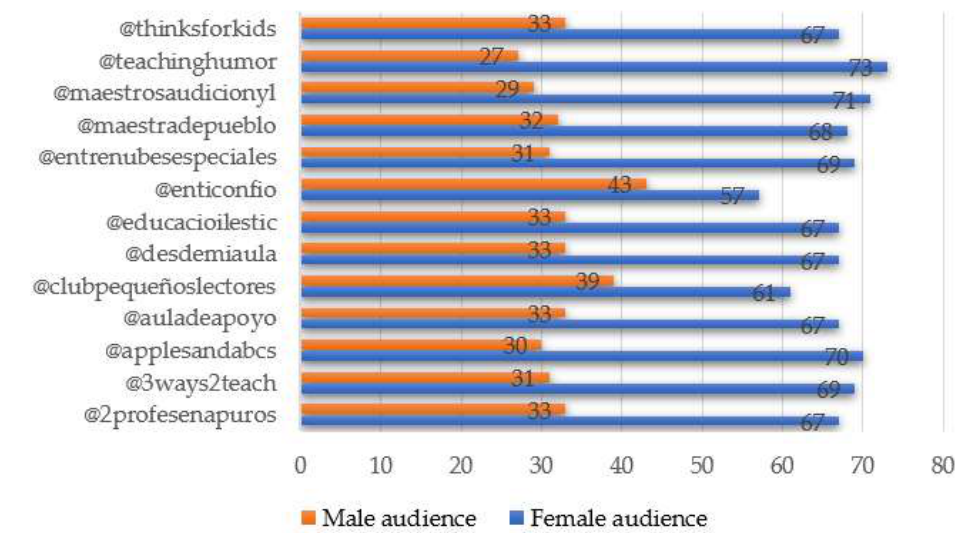
Figure 3. Percentages by gender. Source: own elaboration.